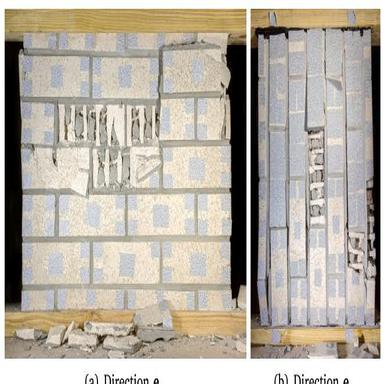
Compression failure of masonry samples in direction 1 and 2.